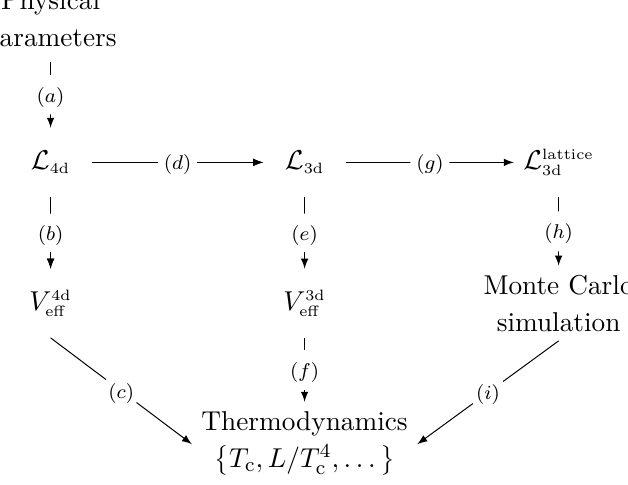
Figure 2 . Three different approaches towards the thermodynamics of the electroweak phase transition. We focus on the purely perturbative 3d approach with steps ( d ) and ( e ) for a real scalar theory and the Standard model supplemented by a real scalar